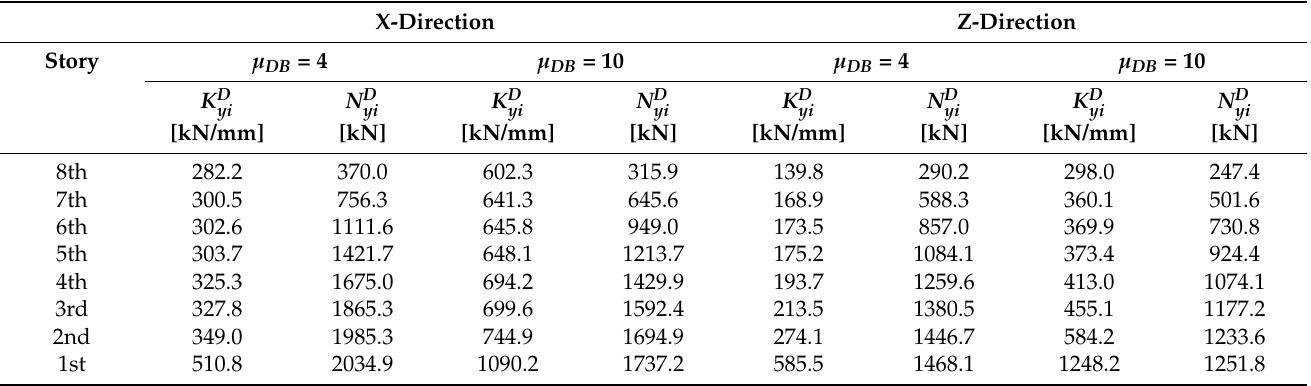
Table 6. Eight-story MRF: elastic stiffness K D and Z-directions for µ DB = 4 and µ DB =